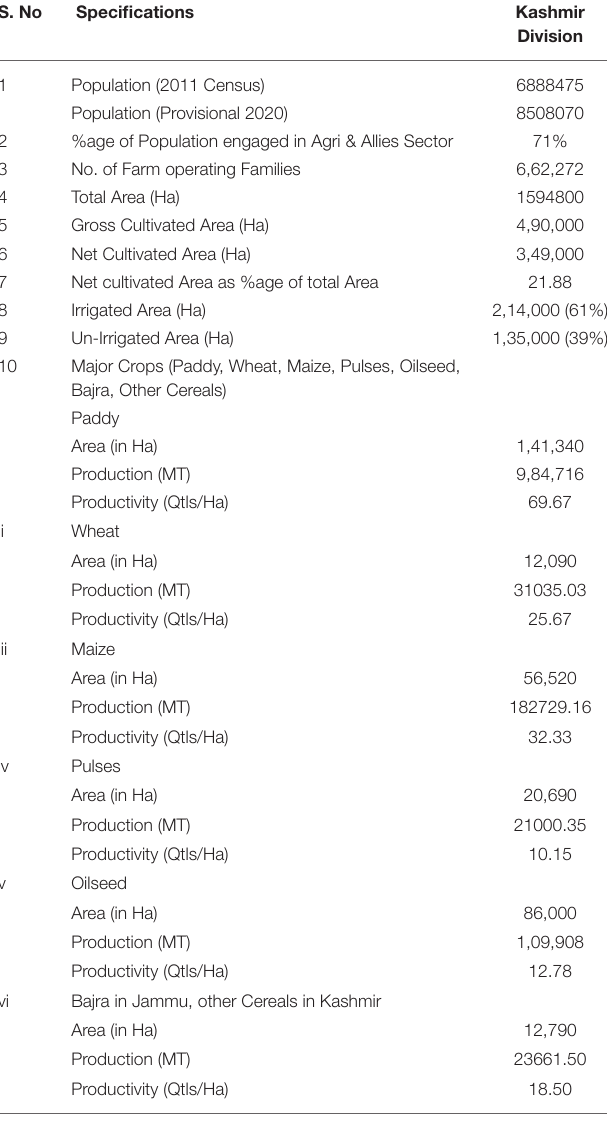
TABLE 1 | Major crops cultivated in Kashmir Himalaya and the percentage of population dependant on agriculture activities (Source: Agriculture Department,